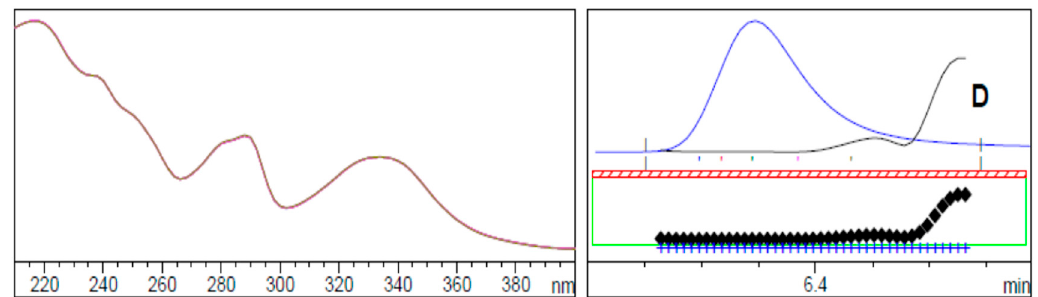
Figure 3. UV spectrum and peak purity curves of ( A ) daclatasvir, ( B ) sofosbuvir, ( C ) ledipasvir, and ( D ) simeprevir determined by a photodiode array (PDA) detector.